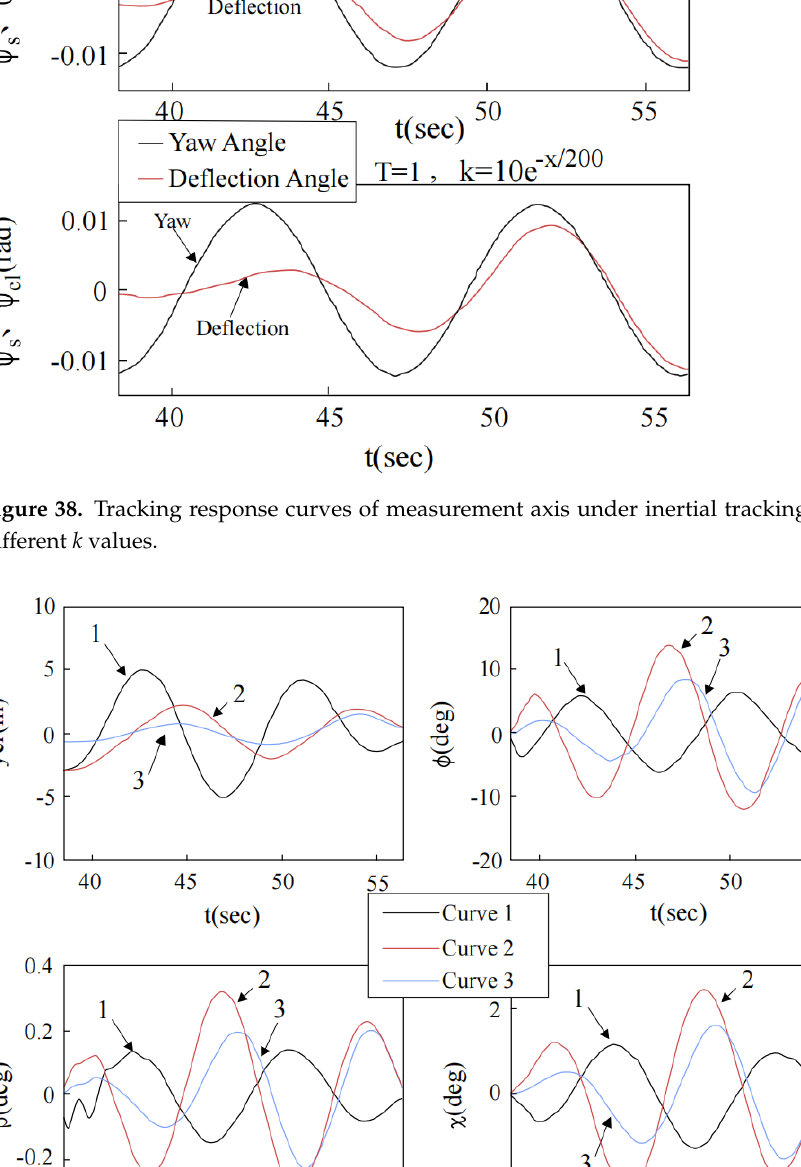
Figure 39. The deck motion compensation curves under inertial tracking strategies with different k values.